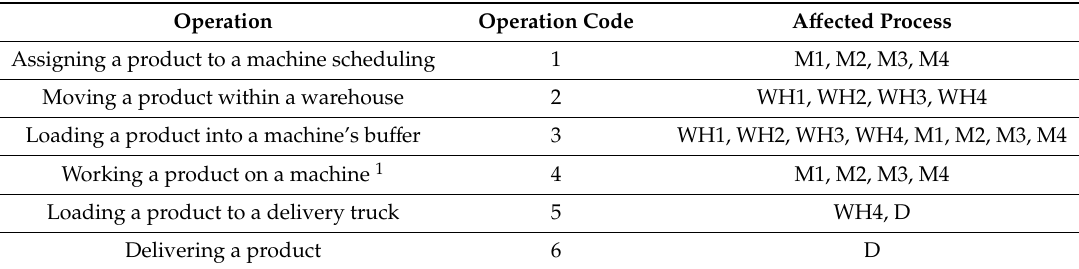
Table 1. Process